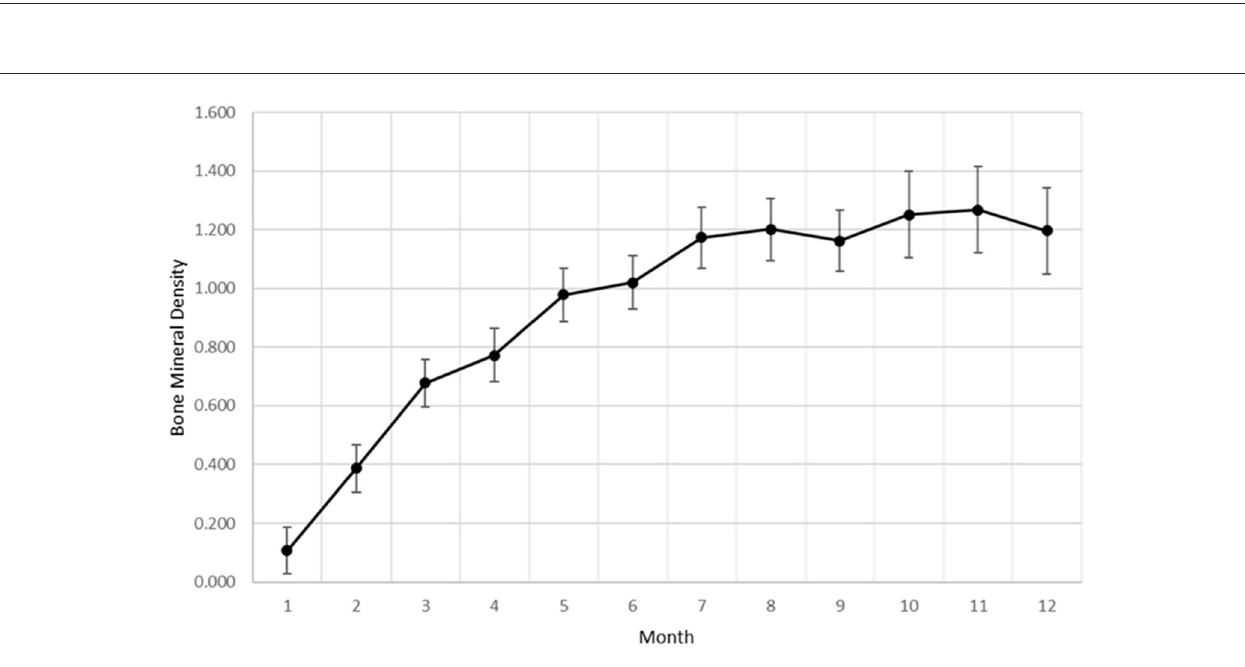
FIGURE2 Bone mineral density data as a factor of time generated from DEXA